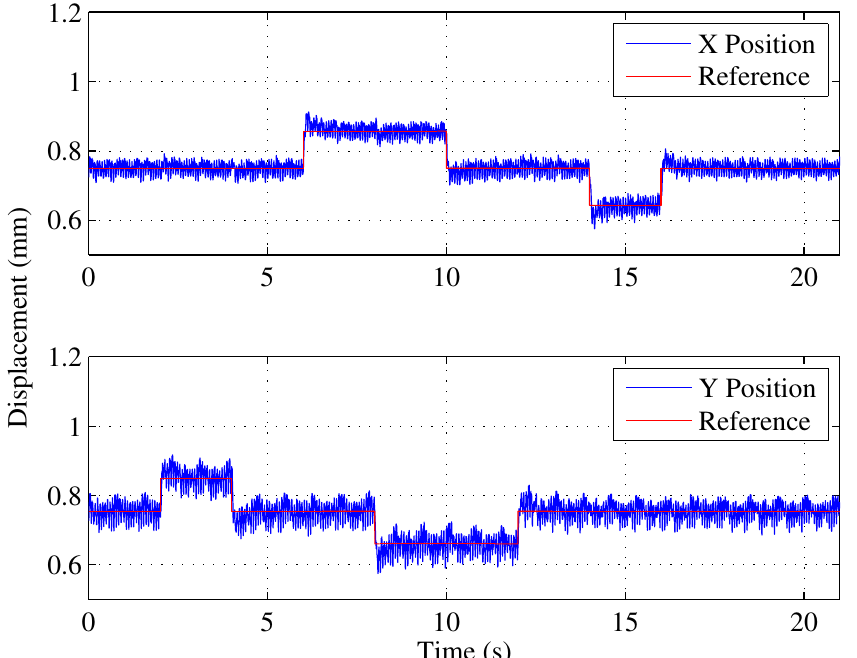
Figure 12. Position controllers output for step input references changes—two-phase system with a radial load.